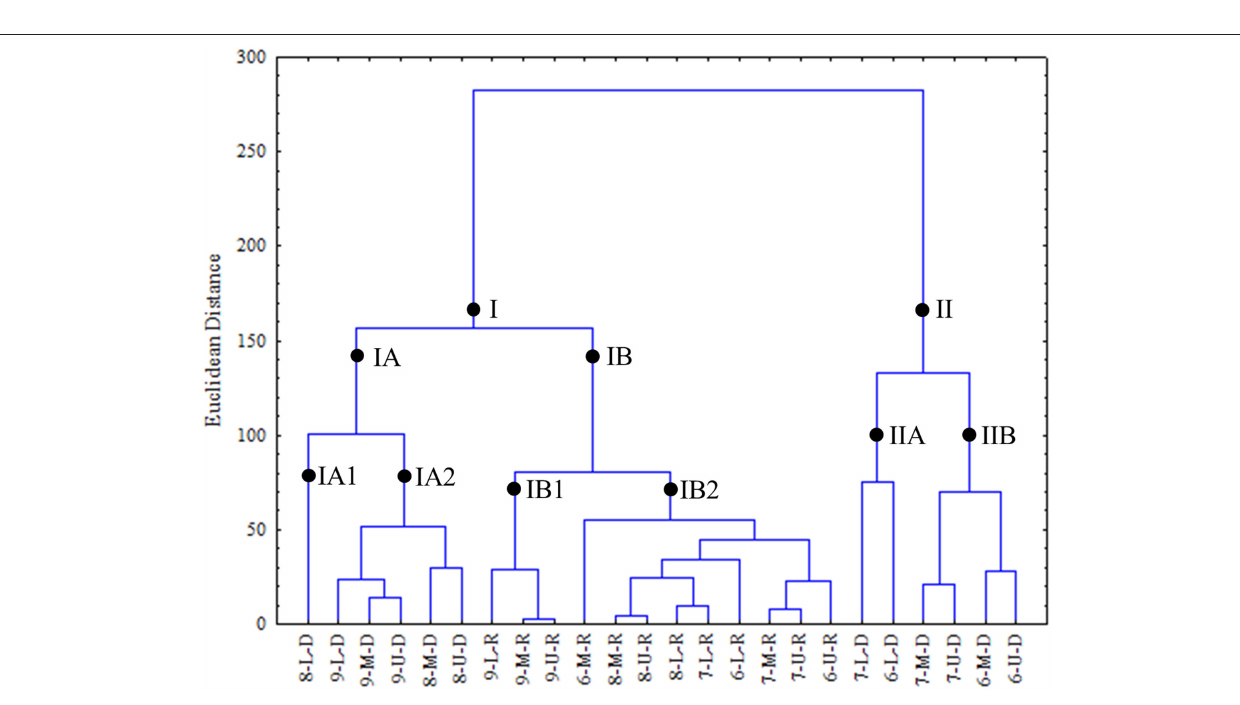
FIGURE 8 | Cluster of interannual seasonal averages of water quality parameters and rainfall at the Goiana River estuary through Euclidean distance. Legend for samples: first numeral represents the year (6 - 2006, 7 - 2007, 8 - 2008, 9 - 2009); second letter represents estuarine area (U, upper; M, middle; L, lower) and third letter represents season (D, dry; R,